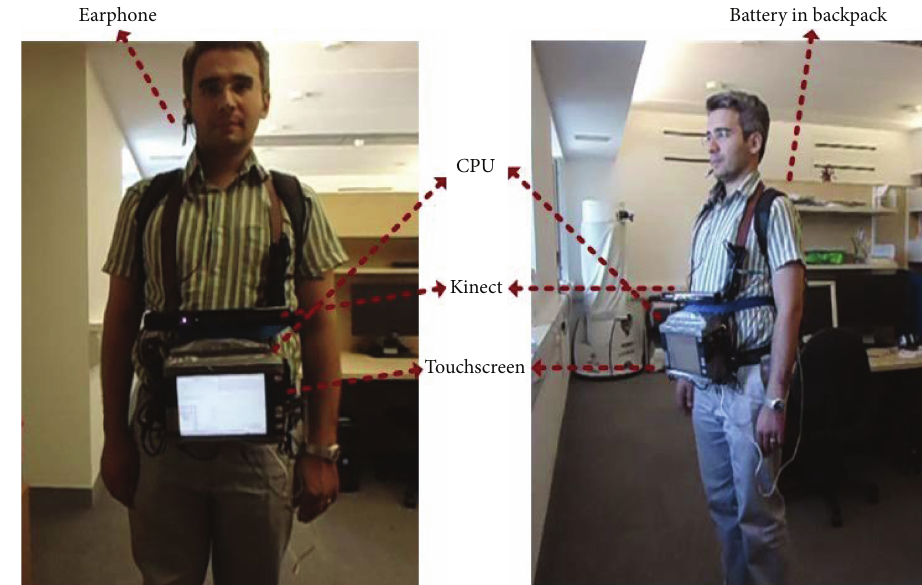
Figure 8: Hardware setup for testing the system.